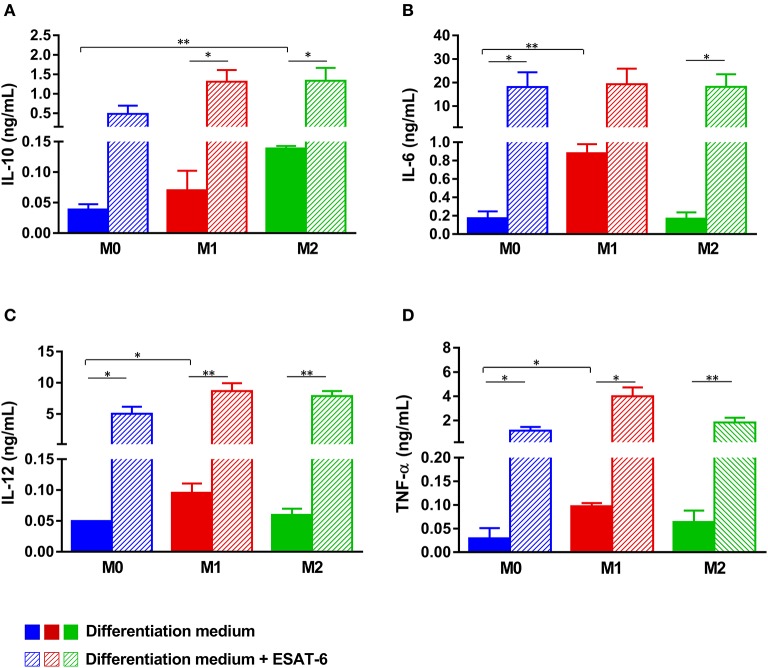
ESAT-6 enhances the pro-inflammatory cytokine secretion by non-polarized M0 and M2 macrophages. Monocytes were differentiated into (i) M0 MΦs by incubation in medium containing human AB serum, (ii) M1 MΦs in medium containing 100 ng/mL GM-CSF and (iii) M2 MΦs in medium containing 10 ng/mL M-CSF. Effects of ESAT-6 were assessed by adding 10 μg/mL of the recombinant protein. Six days later, secretion of IL-10 (A), IL-6 (B), IL-12 (C), and TNF-α (D) was quantified by ELISA. Data are presented as the mean ± SD of 3 separate experiments (i.e., 3 different donors), each one carried out in triplicate. Asterisks indicate statistical significance (*p ≤ 0.05, **p ≤ 0.01).